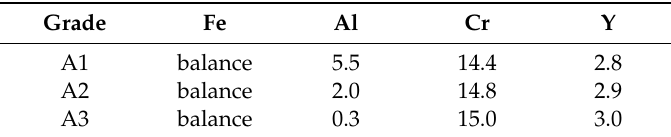
Table 1. The nominal chemical composition of the grades of the new-generation ODS alloy with di ff erent Al content (wt.%). Grade Fe Al Cr